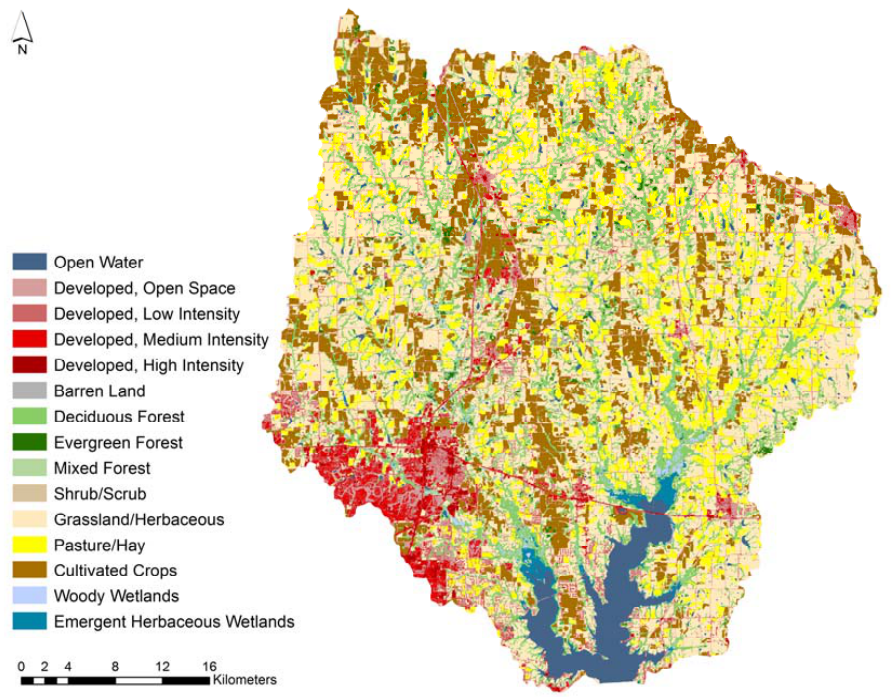
Figure 5. Land use land cover of the Lavon Lake watershed.